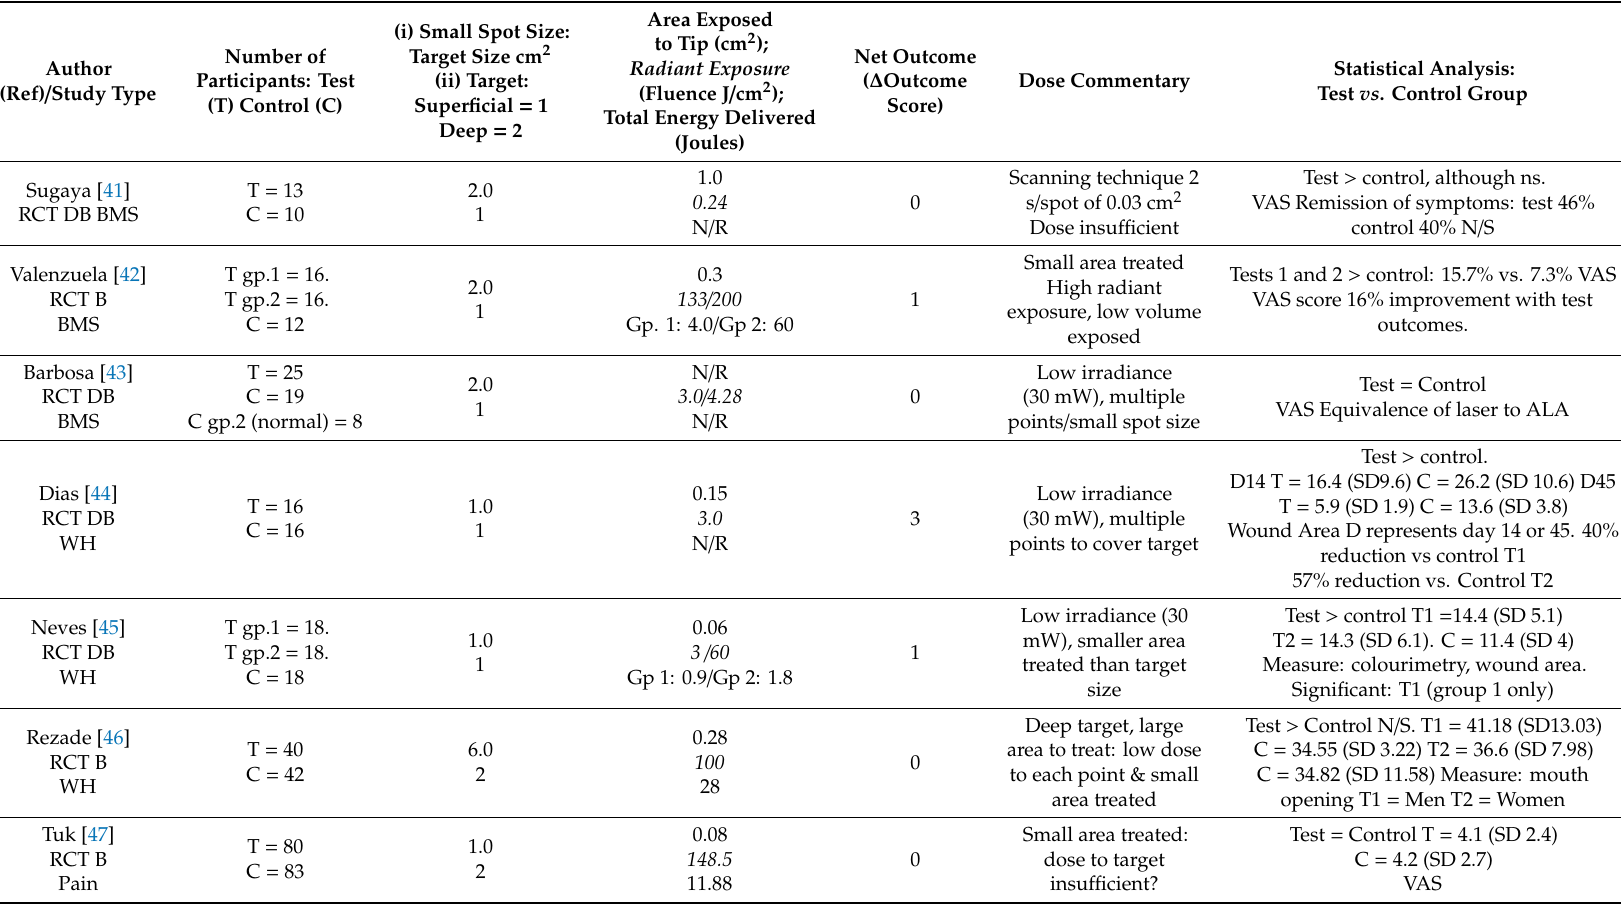
Table 2. Group A. Small spot (0.02 cm 2 to 0.08 cm 2 ) analysis of papers. Outcome key (0–5): 0 = null e ff ect; 1 = 10–20%; 2 = 20–40%; and 3 = 40–60%; 4 = 60–80%; 5 = 80% + . ∆ Outcome Score represents the di ff erence between the outcome scores of the laser treatment (T) and control (C) groups, with the latter subtracted from